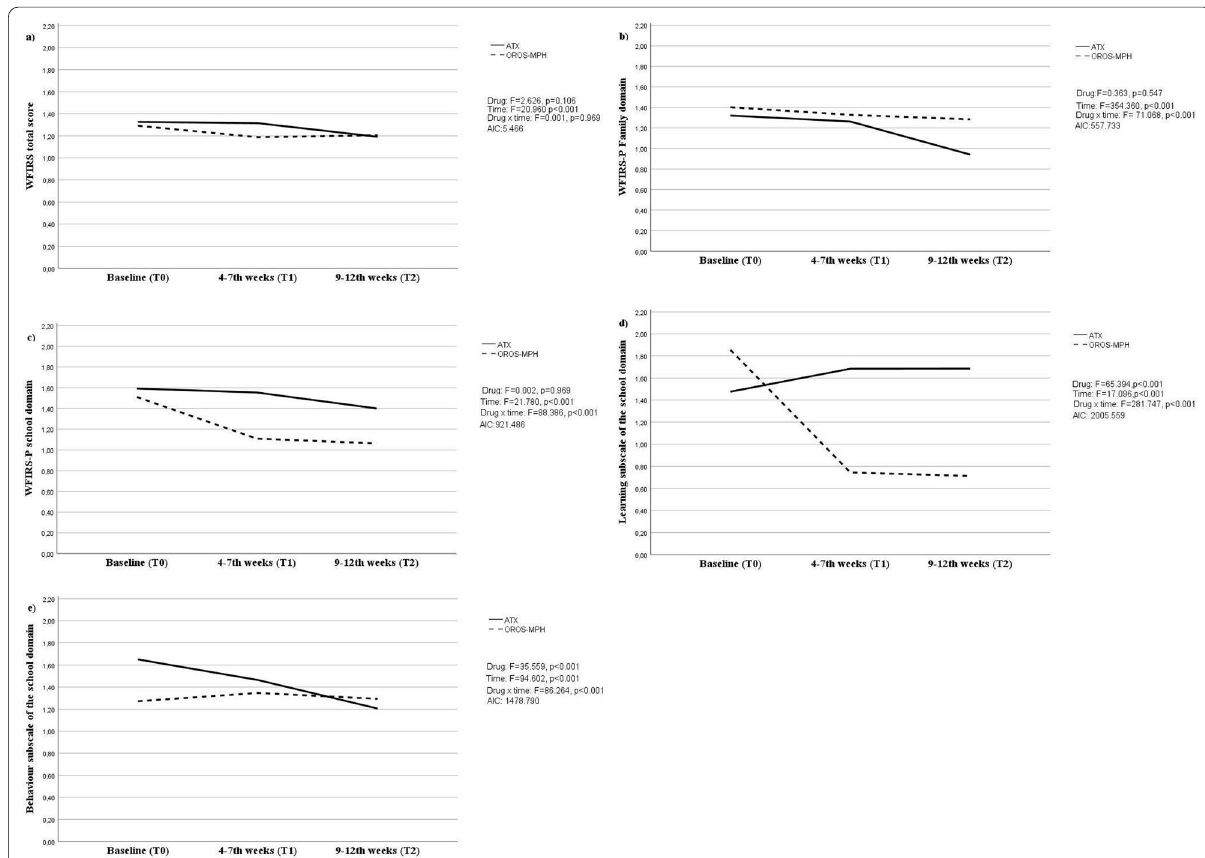
Fig. 3 Line chart depicts the result of mixed-model repeated-measures analysis of functional impairment. † ATX atomoxetine, OROS-MPH osmotic-release oral delivery system methylphenidate, WFIRS-P Weiss Functional Impairment Rating Scale-Parent Report, AIC Akaike information criterion. a Is total score, b is family domain, c is school domain, d is learning subscale of the school domain, and e is behavior subscale of the school